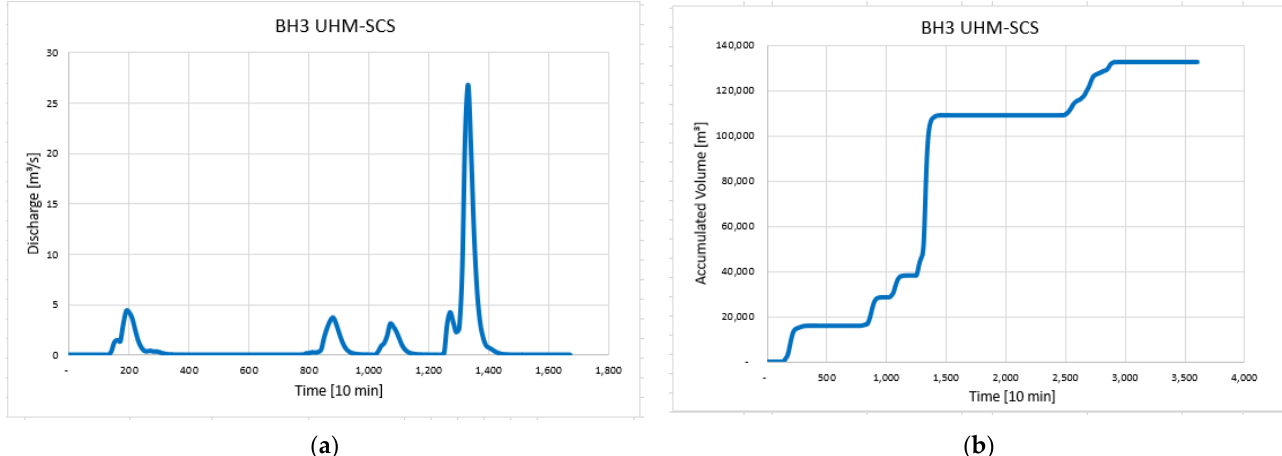
Figure 18. Simulated flood hydrograph in Hypothesis 1 for the 12–13 September 2013 event: ( a ) discharges and ( b ) flood volume.